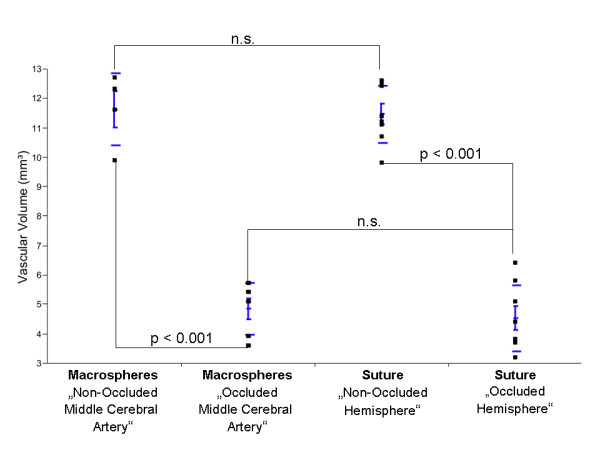
Vascular volume fraction (VVF) in Controls, the Macrosphere- and the Suture Model. Significant differences were found between controls and the macrosphere blocked media territory and the suture technique (p < 0.001). Macrospheres in the middle cerebral artery obtained the same results as the suture technique (p < 0.2).